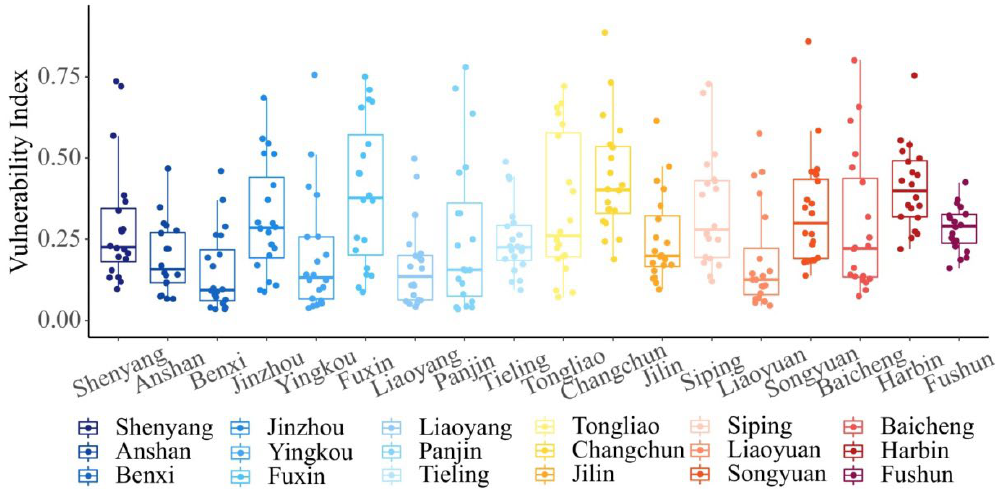
Figure 6. Boxplot of drought vulnerability index of cities in Songliao Plain.